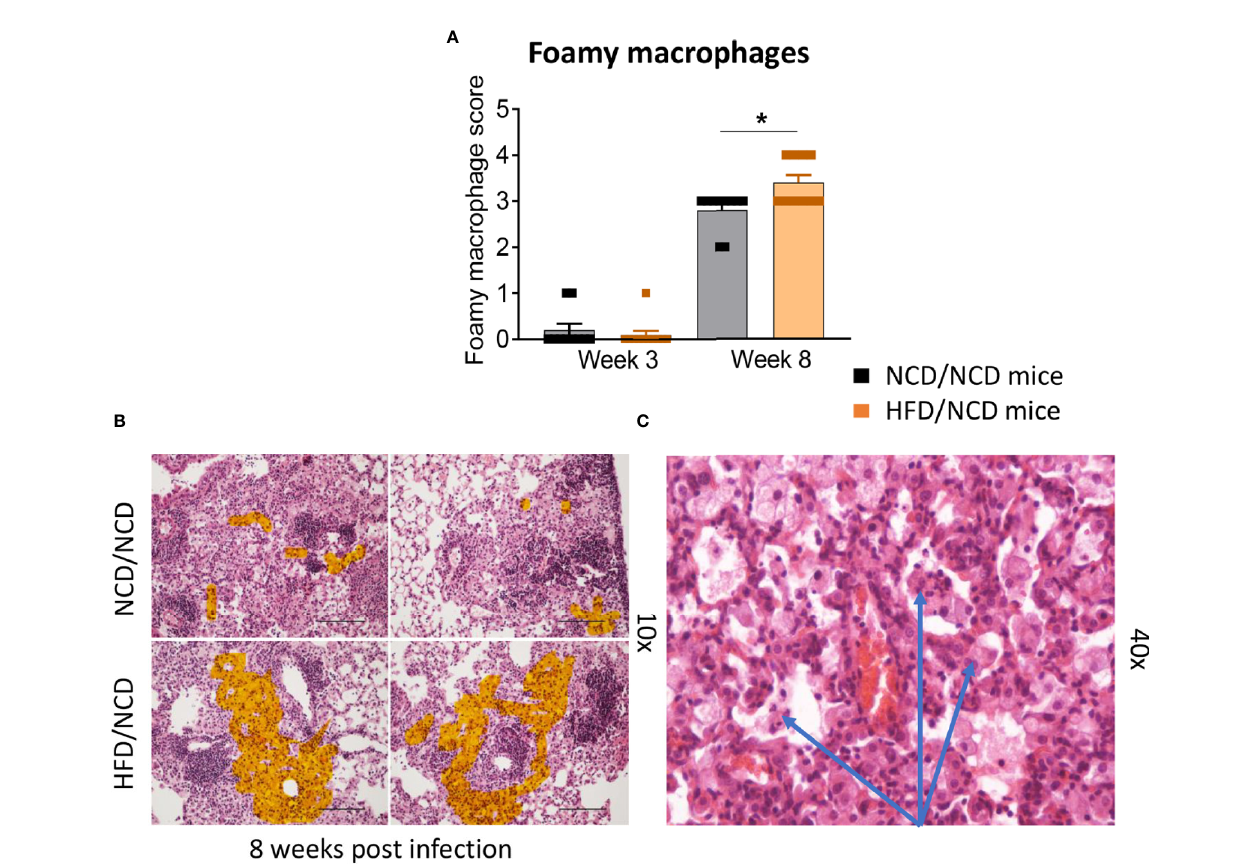
FIGURE 7 | Foamy macrophages were upregulated in the lung of HFD/NCD mice. (A) Histological scoring of foamy macrophages in lung sections of NCD/NCD mice and HFD/NCD mice at 3-and-8 weeks p.i. (B) Representative histological images with highlighted area (orange) of foamy macrophages; (C) Snapshot of foamy macrophages on H&E lung sections (arrows). Data represents mean ± SEM (n=10 mice/group analyzed in one independent experiment). Data analysis was performed by Mann-Whitney U test. *p <